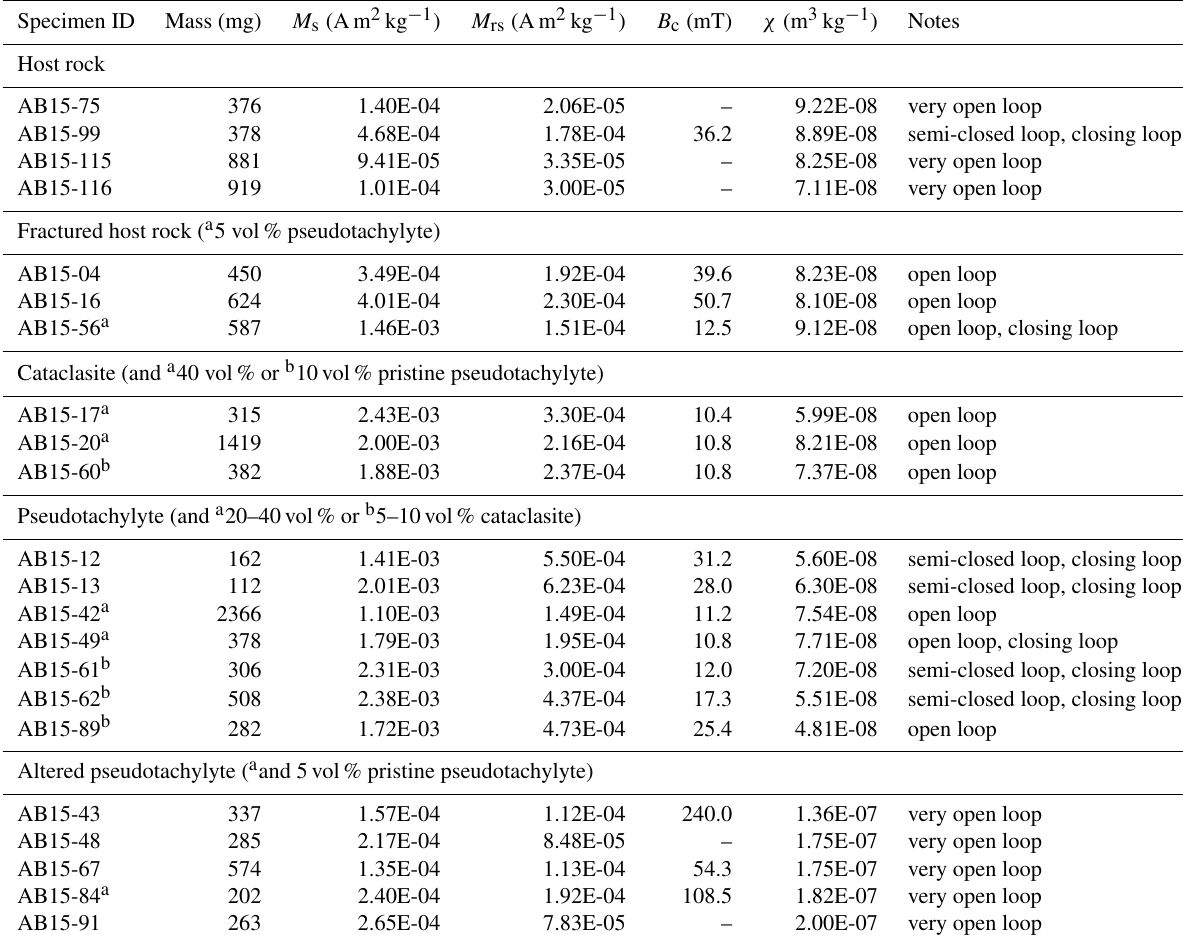
Table 2. Magnetic hysteresis parameters for processed hysteresis loops (automatic drift correction and linear high-field slope correction, with a cut-off field of 567mT). Hysteresis data have been mass normalized. Superscripts a and b in the table refer to relative volume percentages of the different types of fault rock in the samples, as described in Sect.